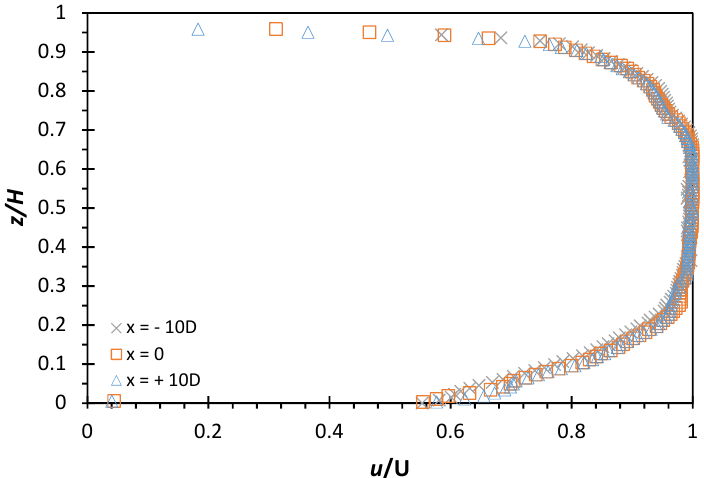
Figure 4. The mean velocity profiles at three different locations at a freestream velocity of U = 0.65 m/s.